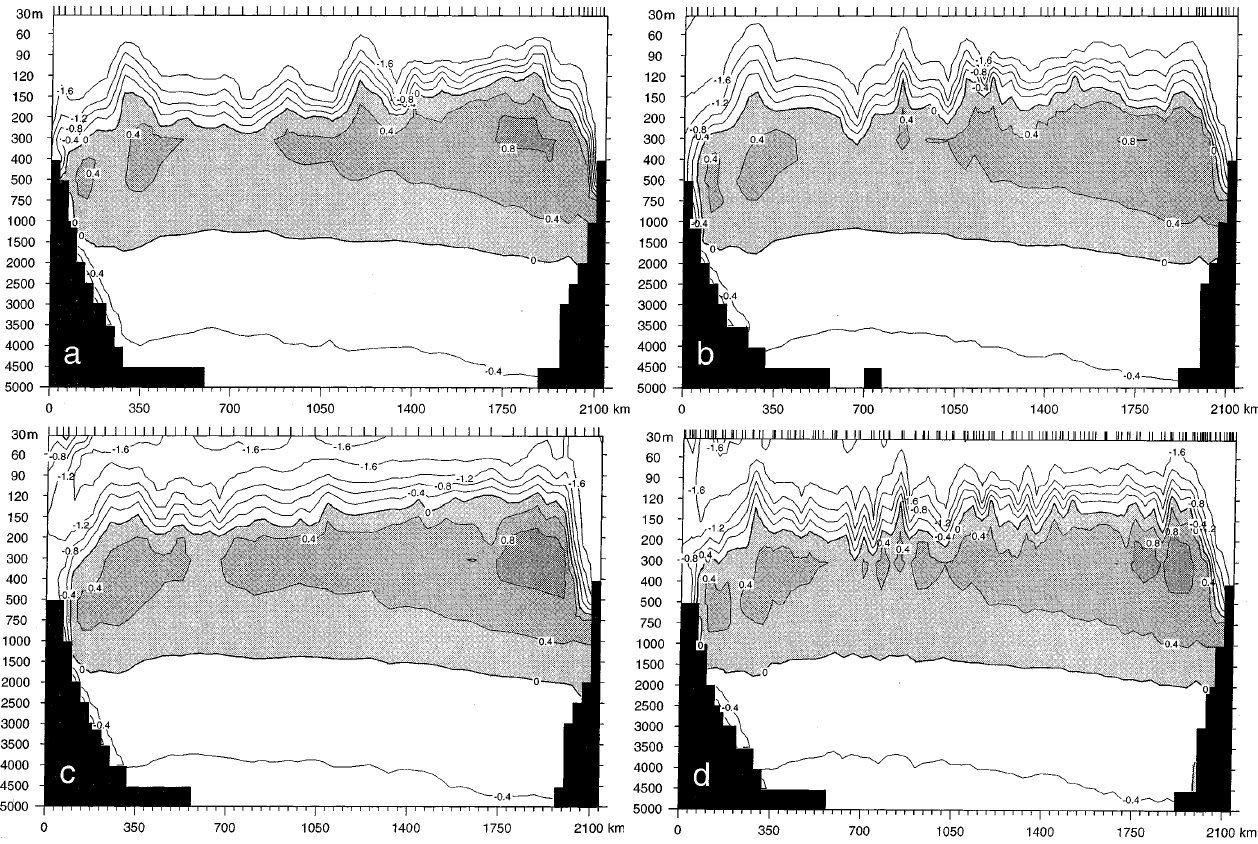
Fig. 2a–d. Temperature fields obtained by linear interpolation of the data measured a in 1989 b 1990 and c 1992–1993 onto the model grid; d shows the composite data set. Station locations are shown by markers the upper part of the maps